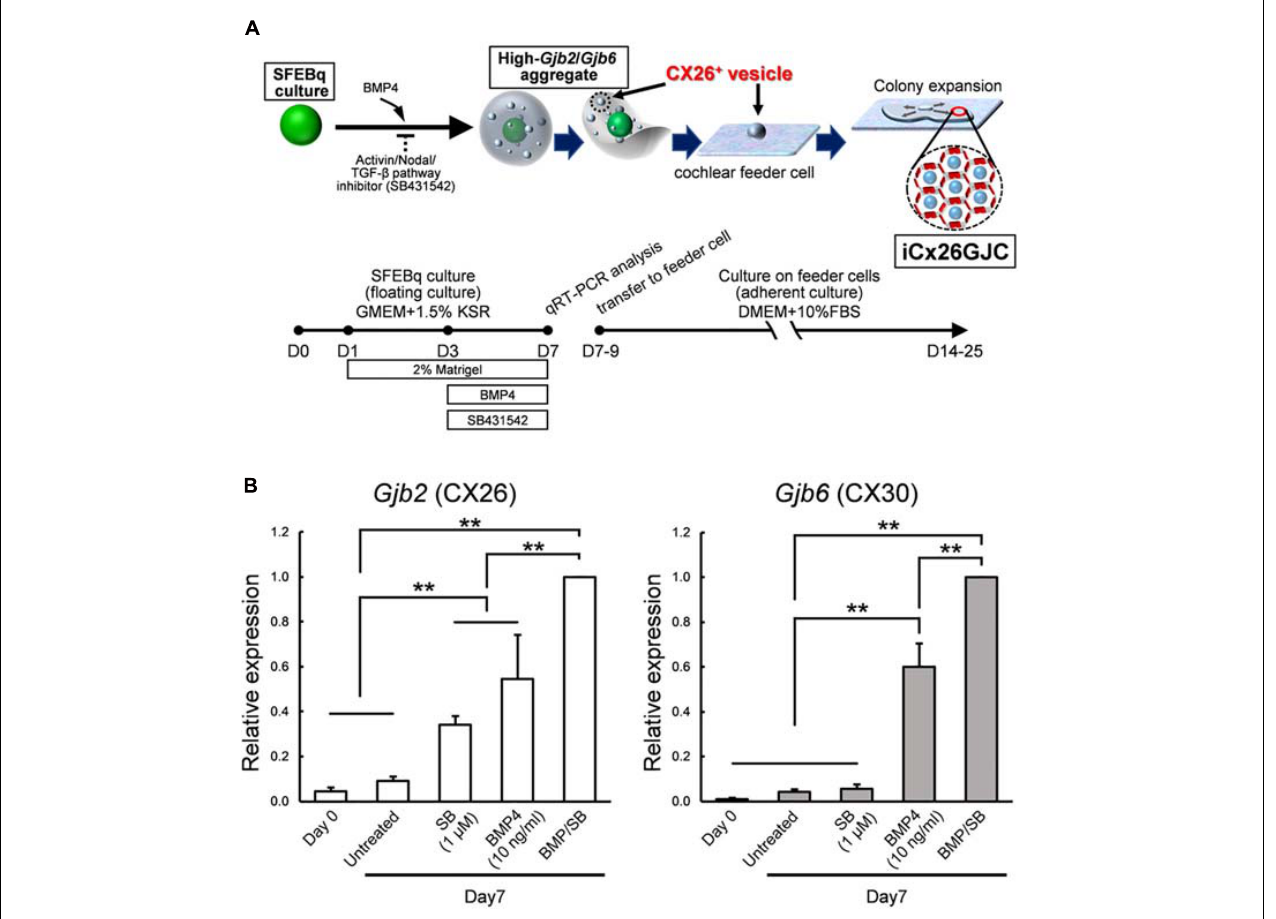
FIGURE 1 | Culture conditions for cells that expressed high levels of Gjb2 (CX26) and Gjb6 (CX30) mRNA. (A) A schematic procedure for differentiating iCx26GJCs from mouse ESCs. SFEBq, serum-free floating culture of embryoid body-like aggregates with quick reaggregation; KSR, knockout serum replacement; BMP4, Bone morphogenetic protein 4; SB431542, Activin/Nodal/TGF- β pathway inhibitor. (B) Relative expression of mRNA at day 0 (for undifferentiated ESCs) and at day 7 for untreated, BMP4-treated, SB-treated, and BMP4/SB-treated aggregates. mRNA expression levels were normalized to those of BMP4 cultures on day 7. The data are expressed as the mean ± SE from five independently generated cell cultures per treatment; for each replicate, expression was assessed in eight aggregates per treatment. Differences among samples were assessed by one-way ANOVA and Scheffe’s multiple comparison test; ** p <